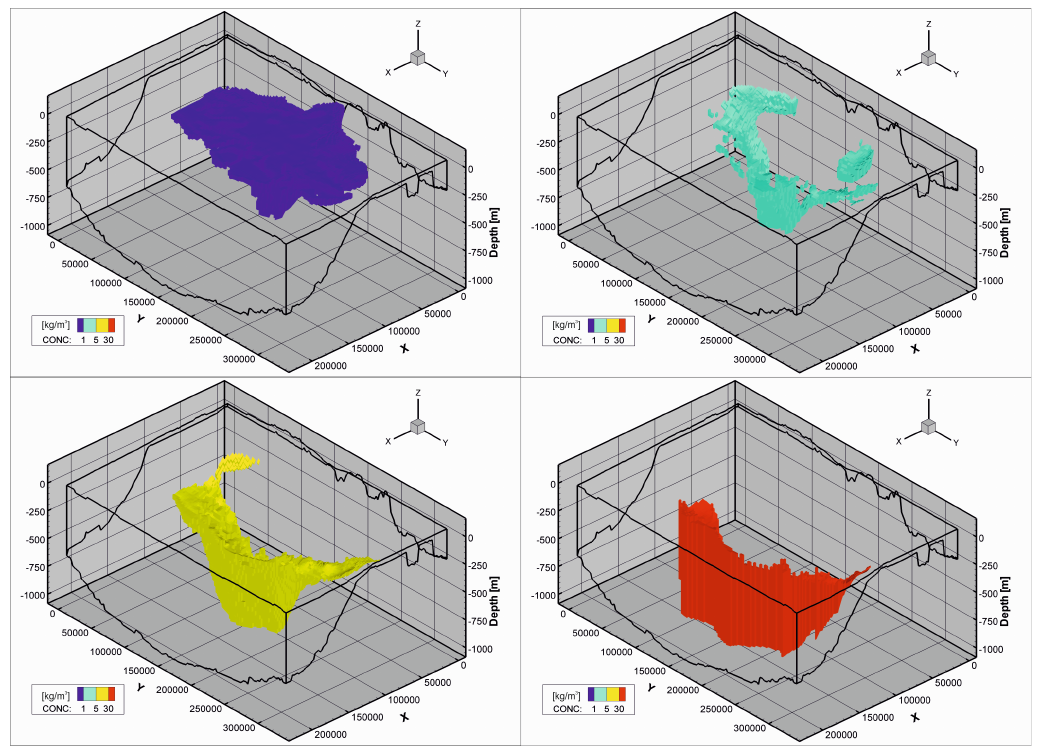
Figure 3. Spatial distribution of different groundwater types in the Nile Delta in 2010 (Concentration in kg/m 3